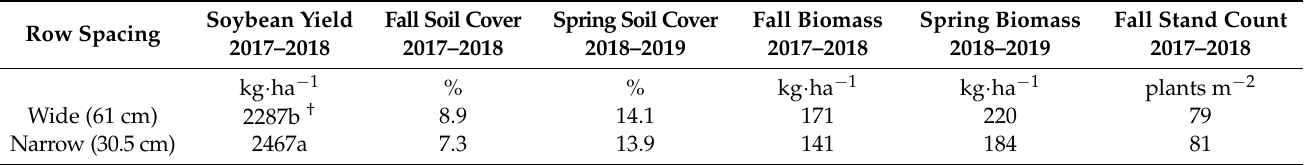
Table 9. Soybean seed yield, fall and spring cover crop soil green cover, cover crop biomass, and cover crop stand count readings for two row spacings averaged across cover crops and relative maturity across five environments planted at Fargo and Casselton, ND, 2017, 2018, and 2019. Soybean Yield Row Spacing